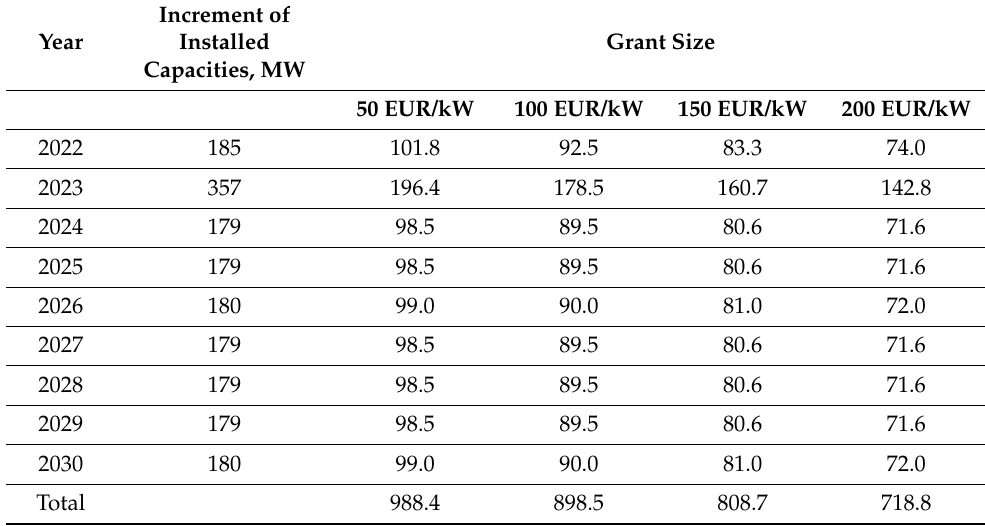
Table 5. Funds needed to be invested on top of the investment grant, EUR 2021